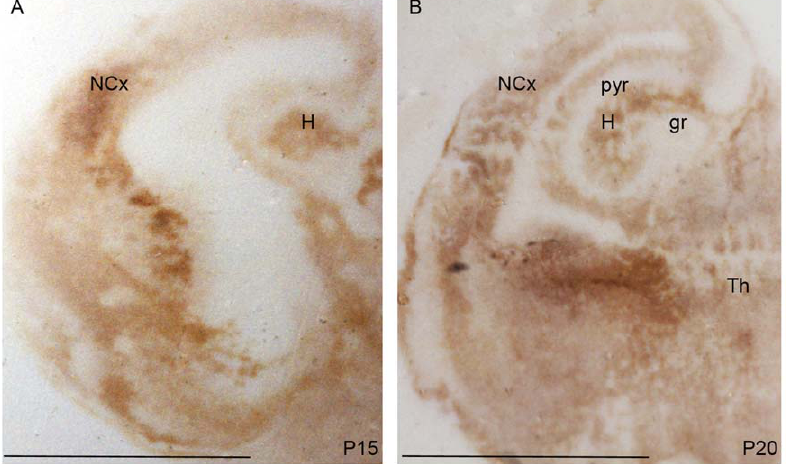
Figure 3. PrP C expression in histoblots of P15 and P20 opossum brains. (A–B) In coronal sections of P15 and P20 a PrP C signal was detected in the thalamus (Th), in the neocortex (NCx) and in the hippocampus (H). The pyramidal cell layer (pyr) and the granule cell layer (gr) of the hippocampus were not stained by PrP C (Bars: A–B 4 mm).